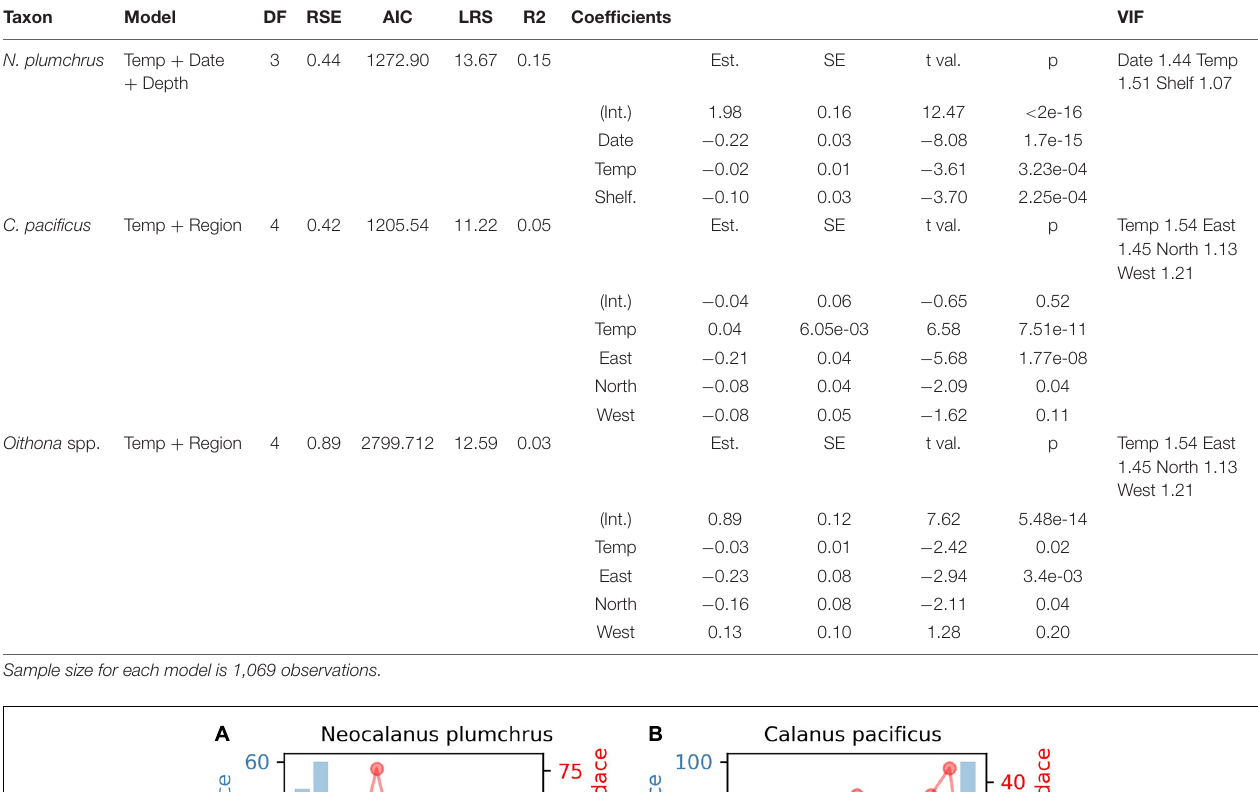
TABLE 1 | Model selection for copepod abundance.